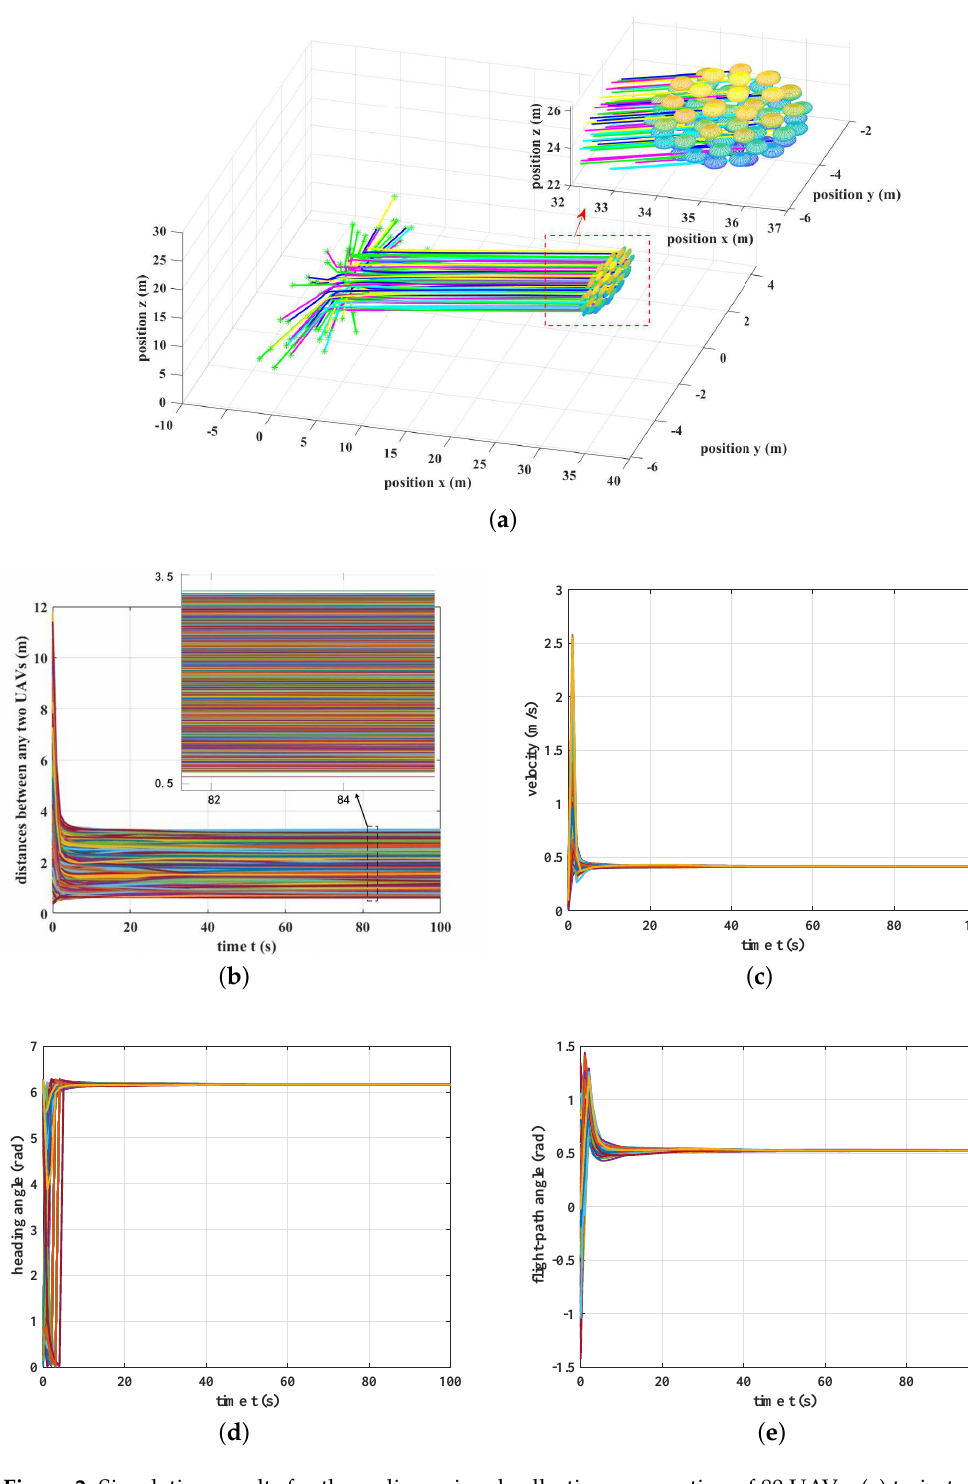
Figure 2. Simulation results for three-dimensional collective cooperation of 80 UAVs. ( a ) trajectories of 80 UAVs, and details of the final configuration; ( b ) distances between any two UAVs versus time; ( c ) speeds of 80 UAVs versus time; ( d ) heading angle of 80 UAVs versus time; ( e ) flight-path angle of 80 UAVs versus